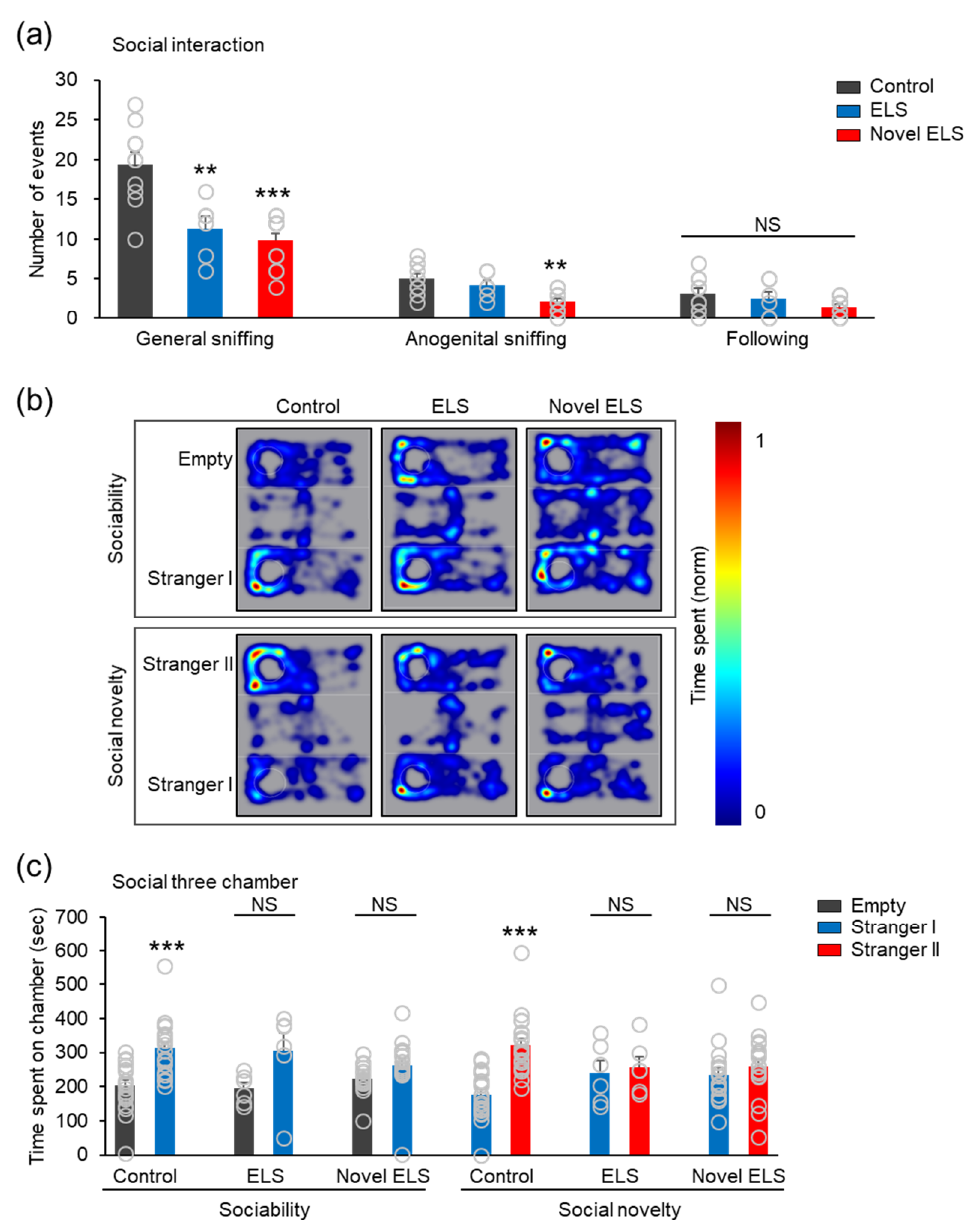
Figure 2. Novel ELS model impairs social behavior. ( a ) Social interaction test. Statistical significance was determined using one-way ANOVA, with Bonferroni’s correction. ** p < 0.01 and *** p < 0.001 vs. vehicle. NS, no significance. ( b ) Representative heat-map images in the three-chamber test for elucidation of the procedure of sociability and social novelty sessions. ( c ) Three-chamber test. Statistical significance was determined between the times spent in the empty chamber and that with Stranger 1, or times spent with Strangers 1 and 2, for each group and condition, using a two-tailed Student’s t -test. *** p < 0.001 vs. opposite chamber. Data represent mean ± SEM. NS, no significance.